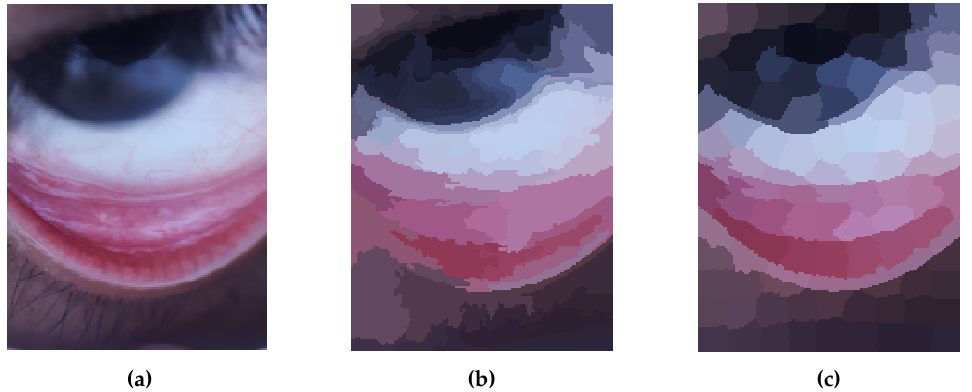
Figure 3. ( a ) Original digital image acquired; ( b ) k-means clustering procedure using only three dimensional (R,G and B) channels from color space; ( c ) proposed k-means procedure with a model in five dimensions retaining both spatial and color